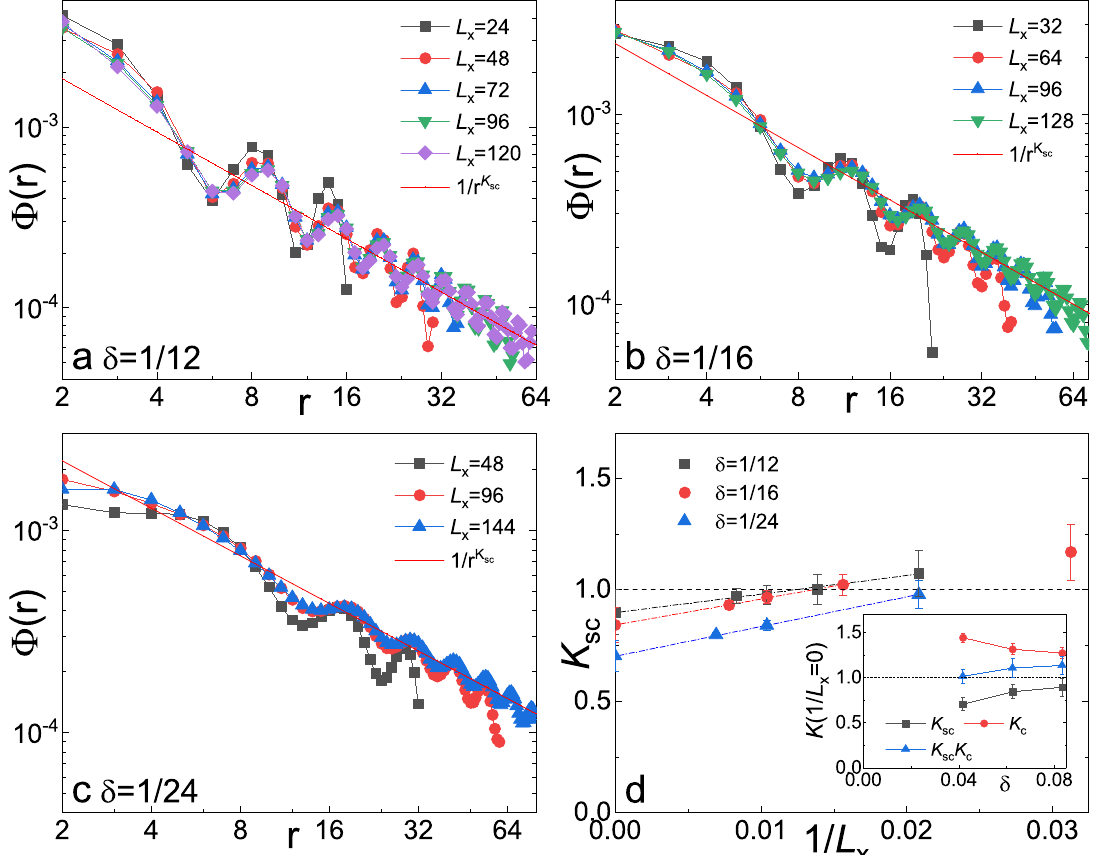
Fig. 3 Superconducting correlations on L y = 4 cylinders. SC correlations Φ aa ( r ) on L y = 4 cylinders of length L x for ( a ) δ = 1/12, ( b ) δ = 1/16, and ( c ) δ = 1/24 on double-logarithmic scales, where r is the distance between two Cooper pairs in the e x direction. The solid lines denote power-law fi tting Φ aa ð r Þ (cid:1) r (cid:3) K sc . d Luttinger exponent K sc as a function of δ and 1/ L x , as well as their extrapolated value in the long cylinder limit 1/ L x = 0, i.e., L x → ∞ . Inset: The extrapolated exponents K sc (1/ L x = 0), K c (1/ L x = 0) in the long cylinder limit 1/ L x = 0 and their product K sc K c as a function of δ . Error bars denote the numerical uncertainty and the dash-dotted lines denote the linear